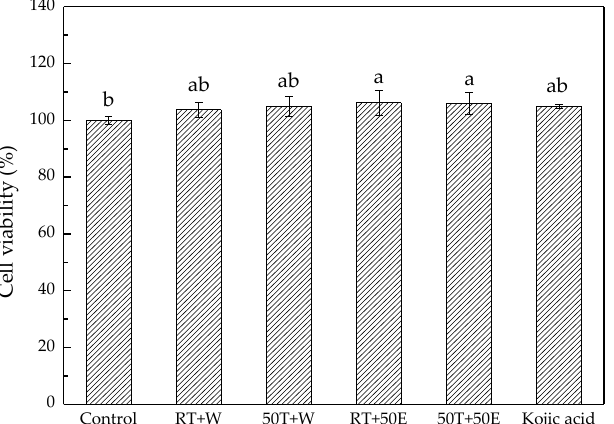
Figure 8. Cell viability of B16/F10 cells treated with the four extracts and kojic acid. Treatment means with the same letter are not significantly different.